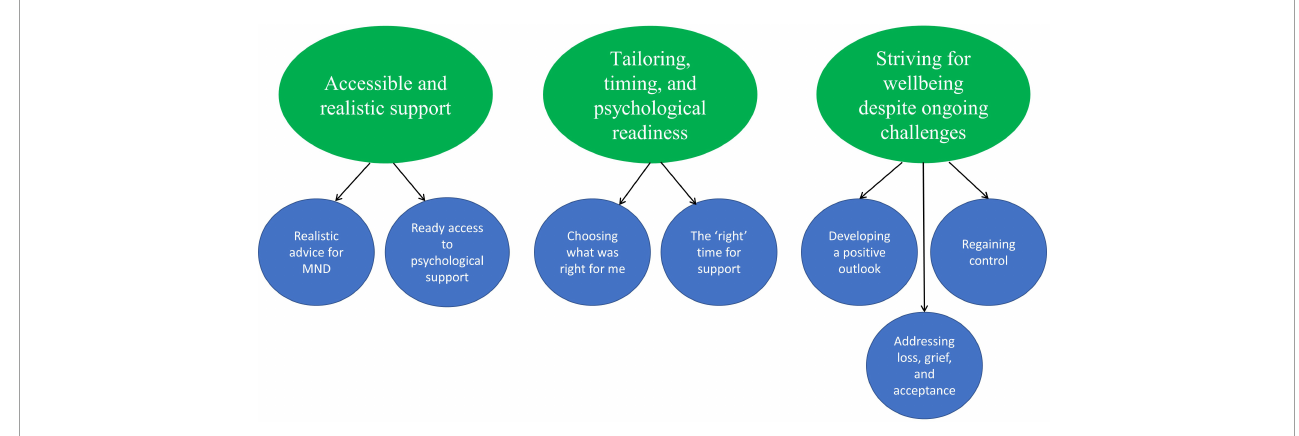
FIGURE6 Thematic map of main themes and corresponding